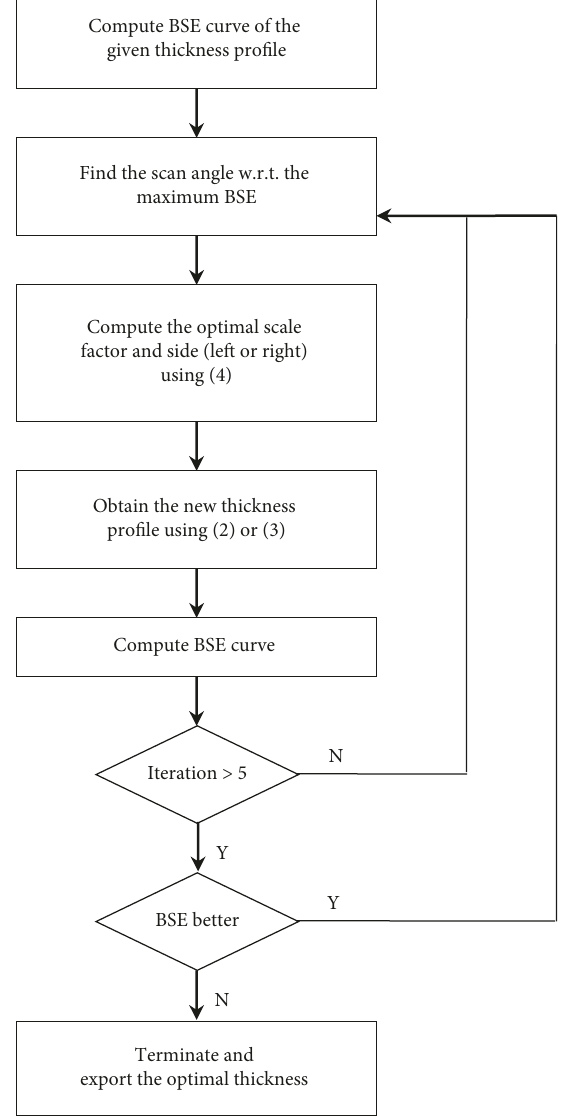
Figure 5: Efficient thickness design